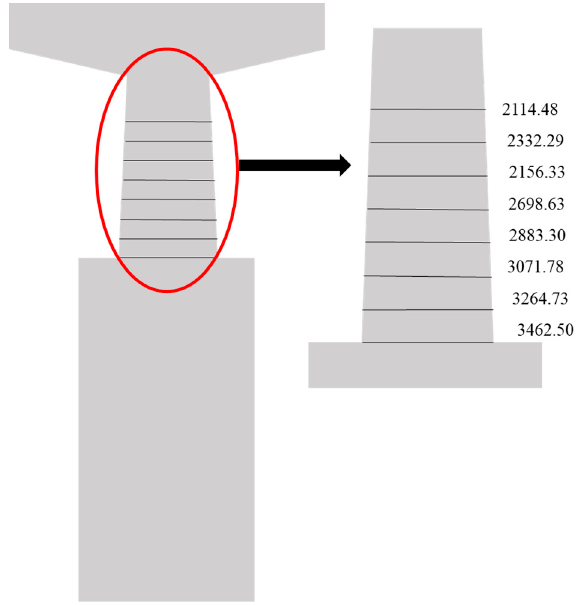
Figure 9. Illustration of the calculated added mass ( kg).